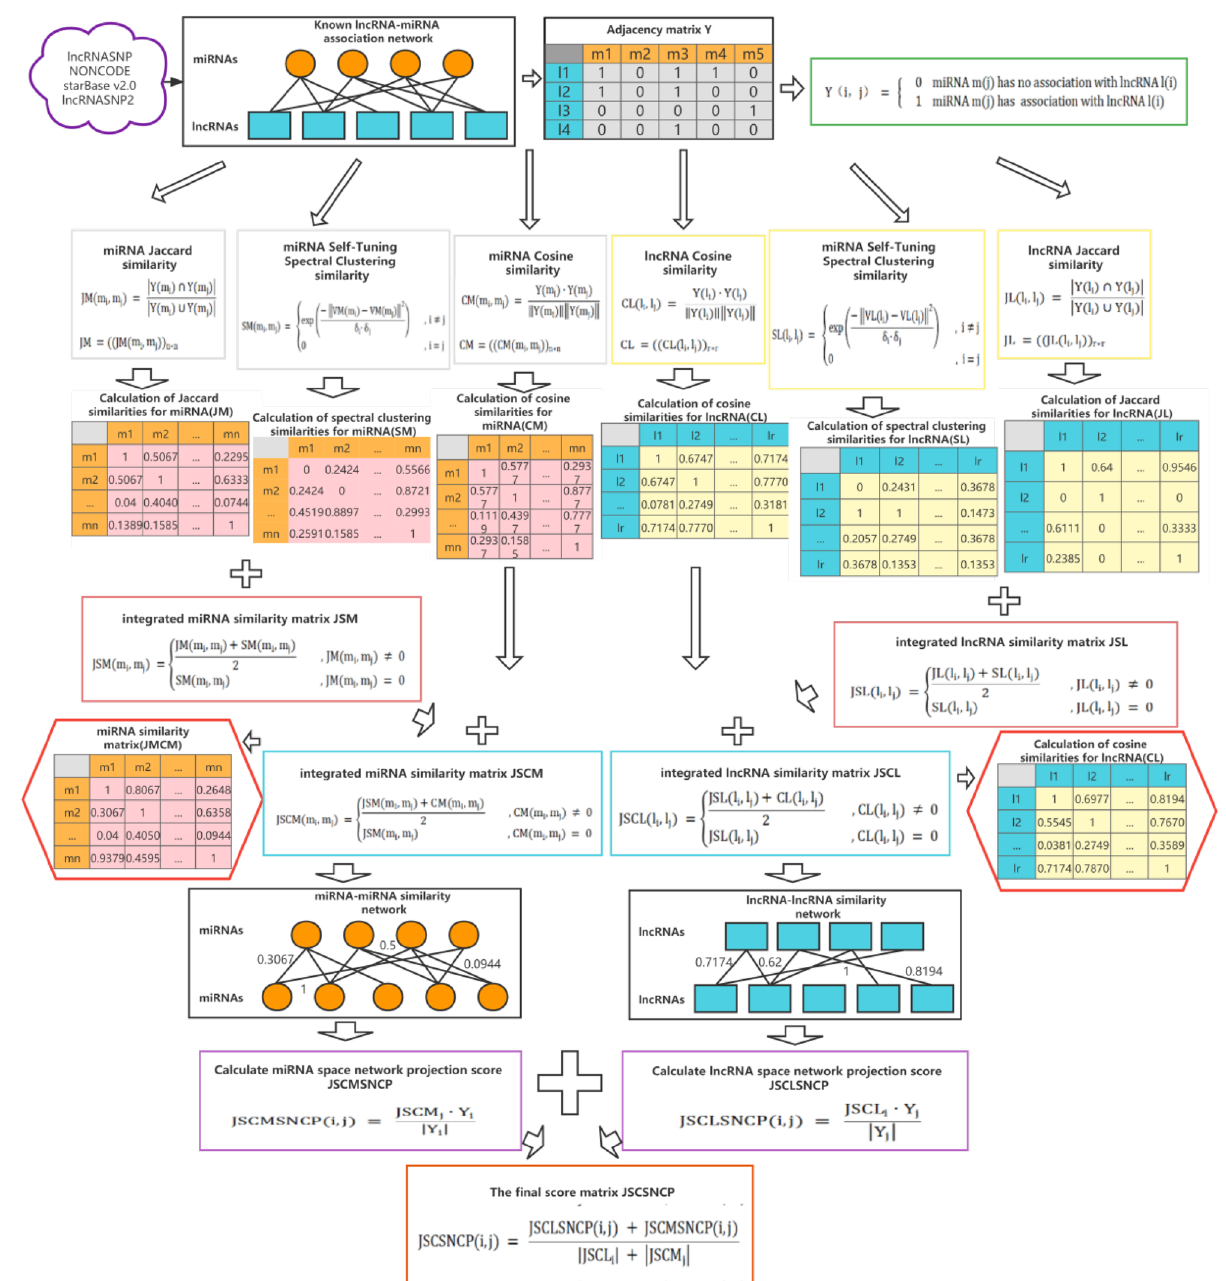
Figure 1. Flow chart of JSCSNCP-LMA applied to lncRNAs–miRNAs association prediction. The JSCSNCP- LMA including four steps: First, construct the lncRNA–miRNA association matrix. Second, calculate